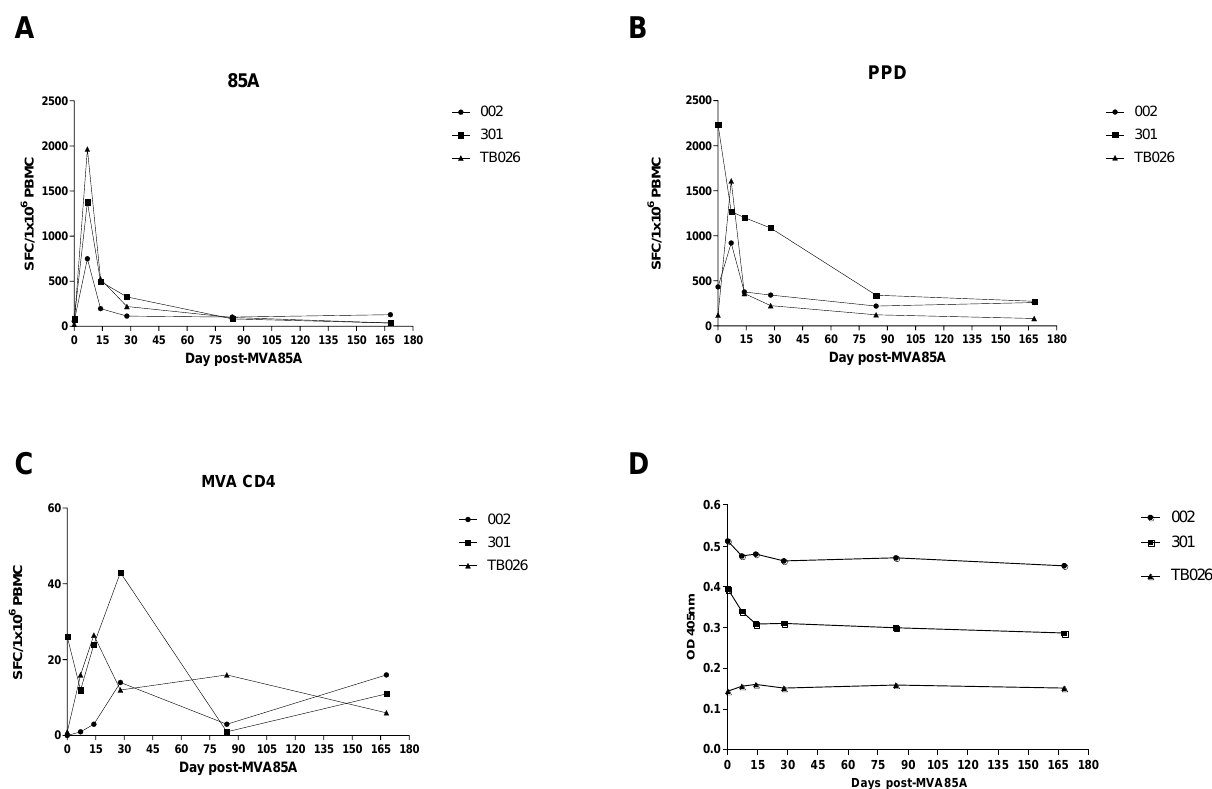
Figure 2. IFN γ enzyme-linked immunospot (ELIspot) responses ( A – C ) or anti-r85A IgG levels ( D ). Frequency of antigen- specific IFN- γ ELISpot responses to ( A ) Ag85A, ( B ) purified protein derivative (PPD), and ( C ) antivector MVA CD4; ( D ) IgG levels against recombinant 85A in serum. x axis: time points in days; y axis: ( A – C ) spots per 1 × 10 6 PBMC, ( D ) absorbance at 405 nm. Circles and squares represent individual readings for two latently infected volunteers in this study, and triangles represent median readings for 10 healthy volunteers who received the same dose of aerosol MVA85A from our previous TB026 study